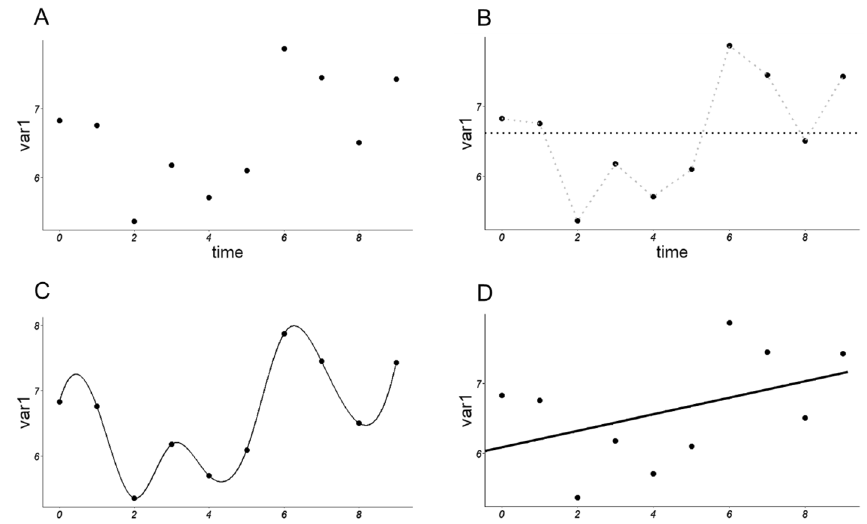
Fig. 1 Differences between measurement of change ( A ), modeling of change ( B , D ) and theories of change ( C ). Panel A Simulated data for a single observation unit examined at ten measurement occasions. Panel B DT autoregressive effects are usually interpreted by reference to a constant process mean. The process mean is represented by the horizontal dotted line. Panel C In theories of change, it is usually assumed that there is continuous existence of observation units and continuous change of variables, which is represented by the solid line connecting successive measurements. Panel D A linear trajectory smoothed through the data, as is done in (linear) growth-curve models. The model-implied trajectory interpolates any time point and can be used to predict values for any time-interval using time as a continuous